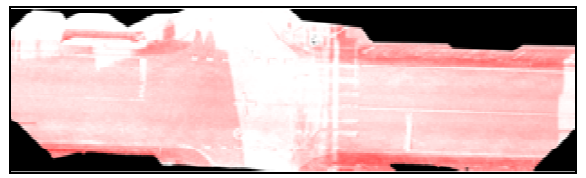
Figure 12. Shadow extraction image （ Sample B ）